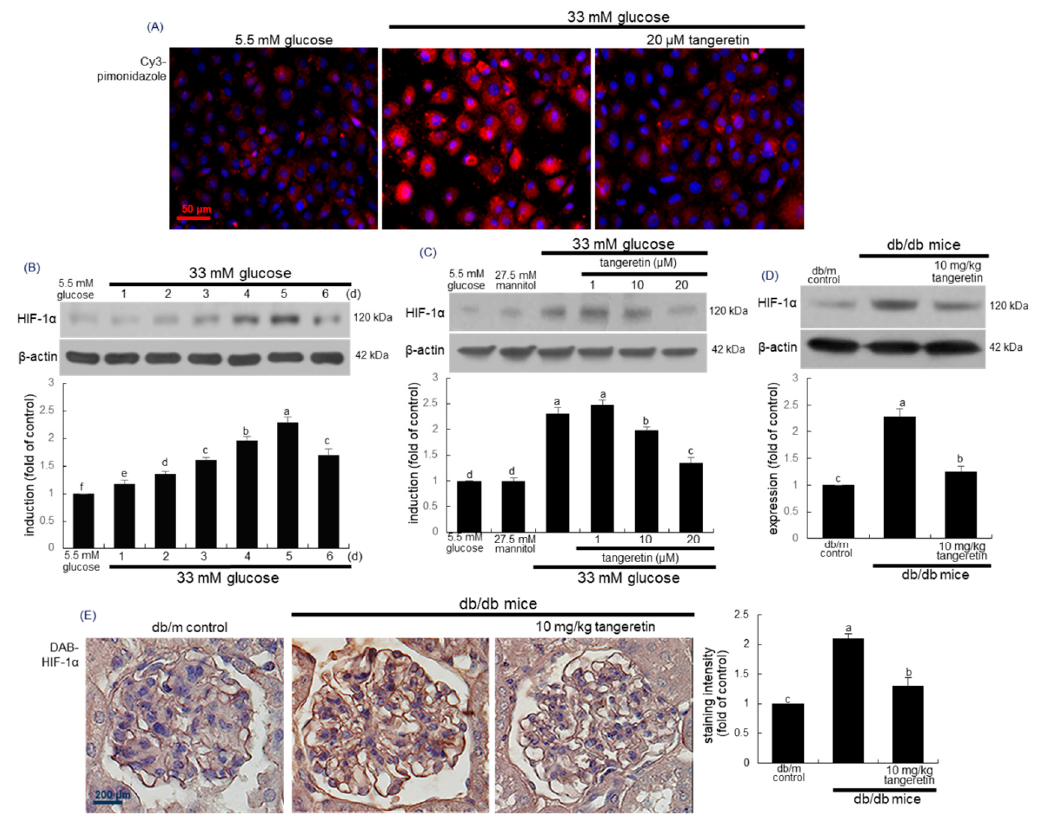
Figure 6. Pimonidazole induction ( A ), temporal expression of HIF-1 α ( B ) and inhibition of HIF-1 α expressions by tangeretin in 33 mM glucose-exposed podocytes ( C ) and diabetic kidney ( D , E ). Podocytes were incubated in media containing 5.5 mM glucose, 5.5 mM glucose plus 27.5 mM mannitol as osmotic controls or 33 mM glucose in the absence and presence of 1–20 μ M tangeretin for 4 days. For the immunocytochemical analysis of pimonidazole ( A ), a Cy3-conjugated secondary antibody was used to visualize the induction of pimonidazole. The nuclear staining was done with DAPI (blue). Each photograph is representative of stained cells. Magnification: 400-fold. The db/db mice were orally supplemented with 10 mg/kg tangeretin for 10 weeks. Cell lysates and tissue extracts were electrophoresed on 8%–10% SDS-PAGE and subject to Western blot analysis with a primary antibody against HIF-1 α ( A – C ). β -Actin antibody was used as an internal control. The bar graphs (mean ± SEM, n = 3) represent quantitative results of blot bands obtained from a densitometer. Values in bar graphs not sharing a common letter are significantly different at p < 0.05. Immunohistochemical staining was conducted to reveal tissue levels of HIF-1 α of diabetic glomeruli ( E ). The glomerular HIF-1 α was confirmed with 3,3 ′ -diaminobenzidine (DAB), producing a brown staining, counterstained with hematoxylin and was quantified. Each photograph is representative of four mice. Scale bar = 50 μ m or 200 μ m.